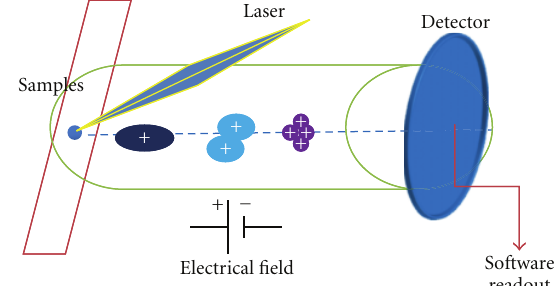
Figure 1: After the samples were dried, a laser-ionized peptides from crystals of the sample and matrix mixture. Then, these ions were accelerated through an external electric field and down into the flight tube. Finally, the detector would measure ions as they reach the end of the tube with software readout the